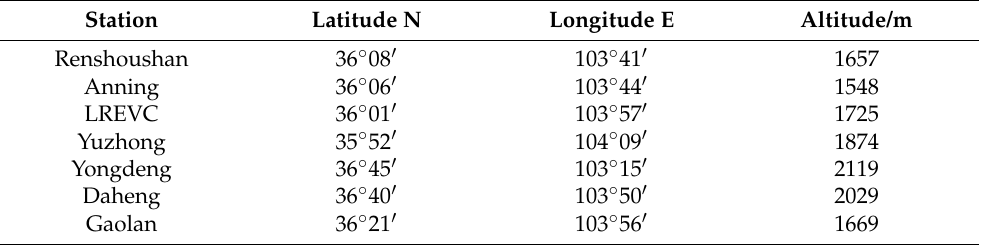
Table 1. Latitude, longitude and altitude of sampling stations in Lanzhou city used in this study.